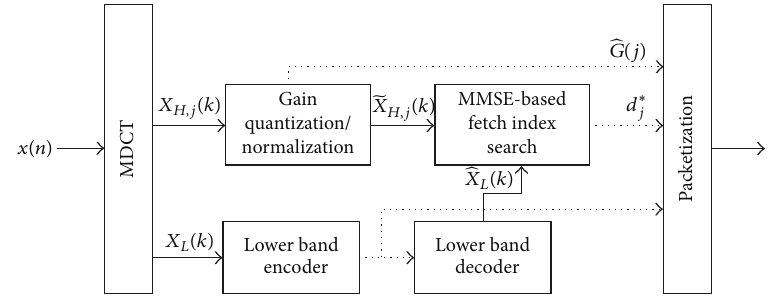
Figure 3: Structure of the proposed SWB extension